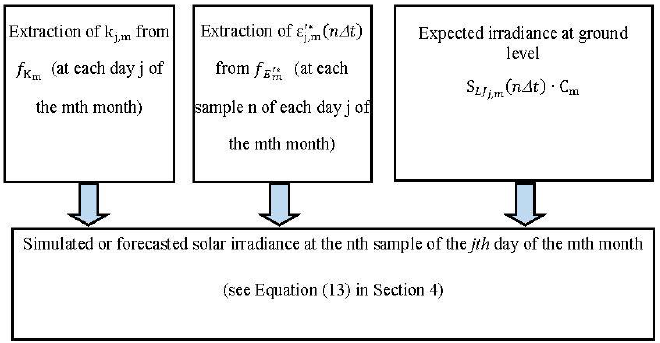
Figure 3. Flow chart of the “Simulation of solar irradiance” stage.